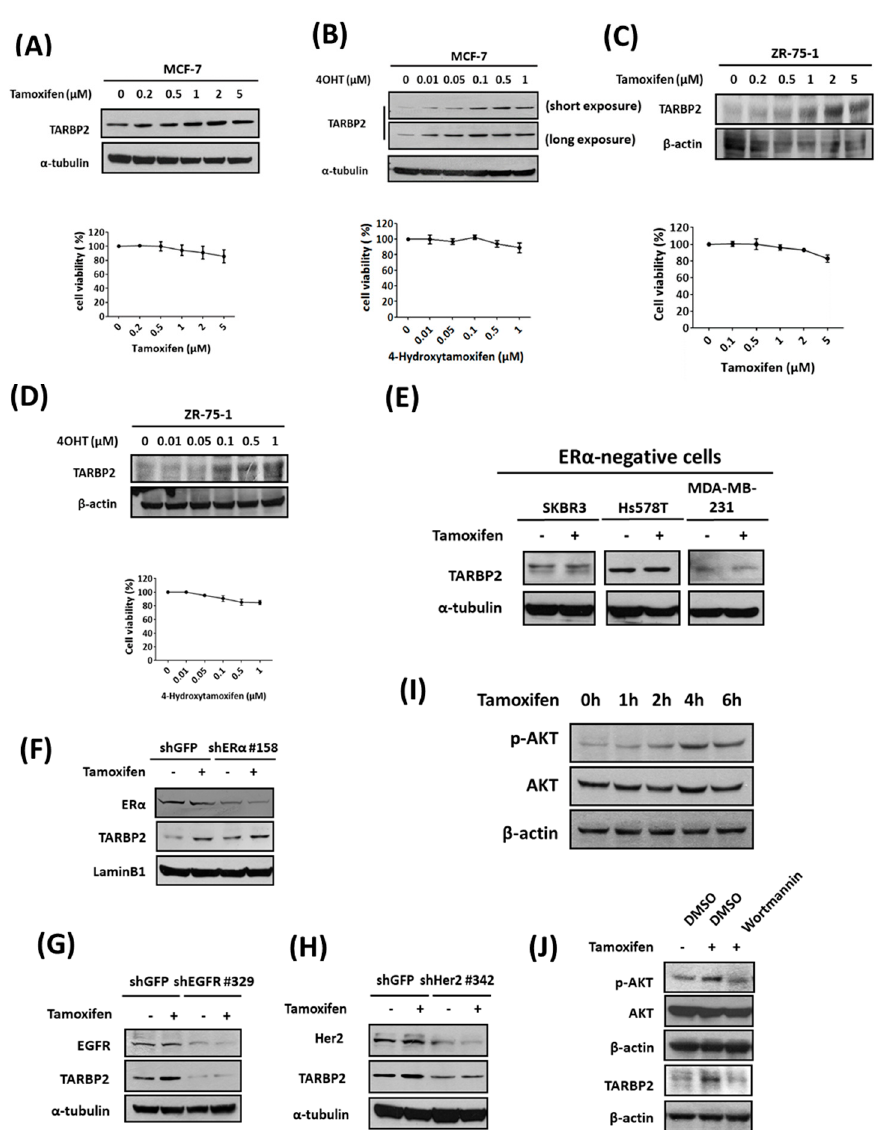
Figure 3. TARBP2 is induced by tamoxifen treatment in ER α -positive breast cancer cells. ( A – D ) Association of TARBP2 expression and tamoxifen treatment in ER α -positive breast cancer cells. MCF-7 ( A , B ) and ZR-75-1 ( C , D ) cells were treated with increasing concentrations of tamoxifen or 4-hydroxytamoxifen for 48 h, and a western blot was performed to examine TARBP2 expression. The cytotoxic effects of the indicated concentrations were evaluated by MTT assay. All MTT results are presented as the means ± SEM from at least three separate experiments that were performed in duplicate or triplicate. ( E ) TARBP2 expression in ER-negative breast cancer cells treated with tamoxifen. ER-negative cells were collected to determine TARBP2 expression by western blot after treatment with tamoxifen for 48 h. ( F – H ) MCF-7 cells were introduced with shRNAs targeting ER α ( F ), EGFR ( G ) and Her2 ( H ) for 48 h; 2 µ M tamoxifen was then then added to the culture medium for 48 h. The cells were harvested to determine the protein expressions by western blot. ( I ) MCF-7 cells were treated with 2 µ M tamoxifen and harvested at the indicated time point to analyze the expressions of p-AKT and AKT by western blot. ( J ) MCF-7 cells were pre-treated 100 nM wortmannin to inhibit AKT phosphorylation for 1 h. After 4 h (p-AKT and AKT) and 48 h (TARBP2) of tamoxifen treatment, the protein expressions were analyzed by western blot.